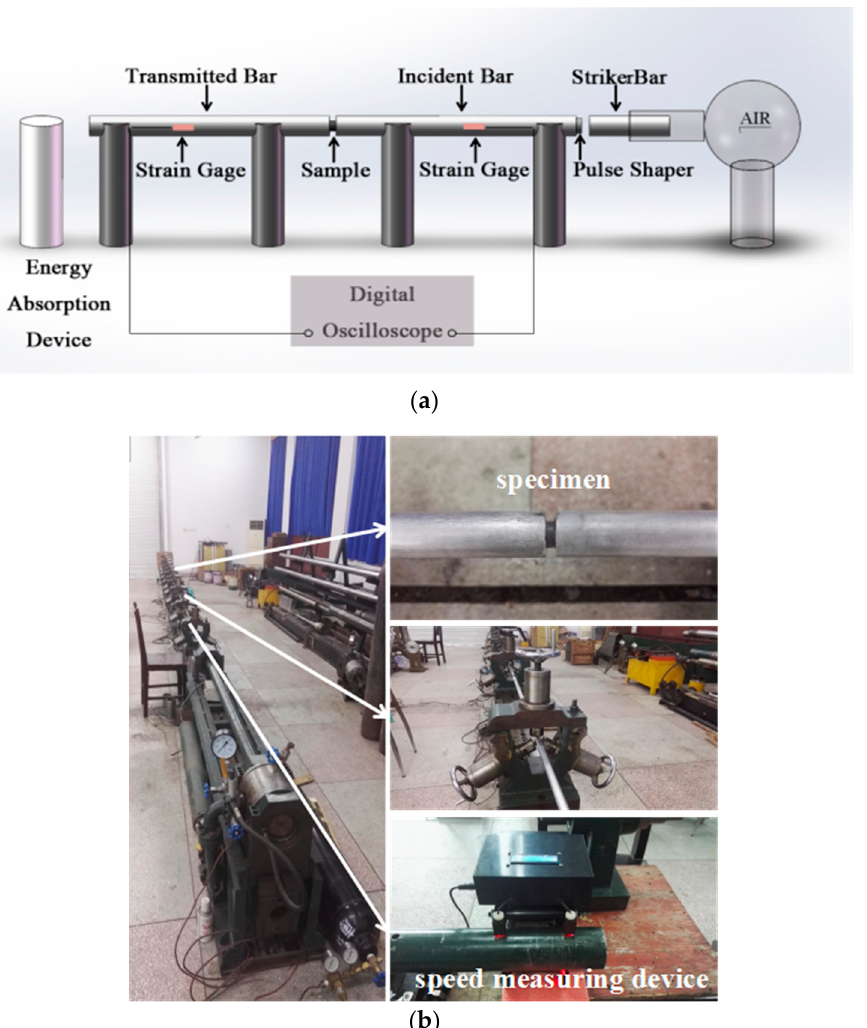
Figure 3. SHPB setup. ( a ) diagrammatic sketch; ( b ) actual device.